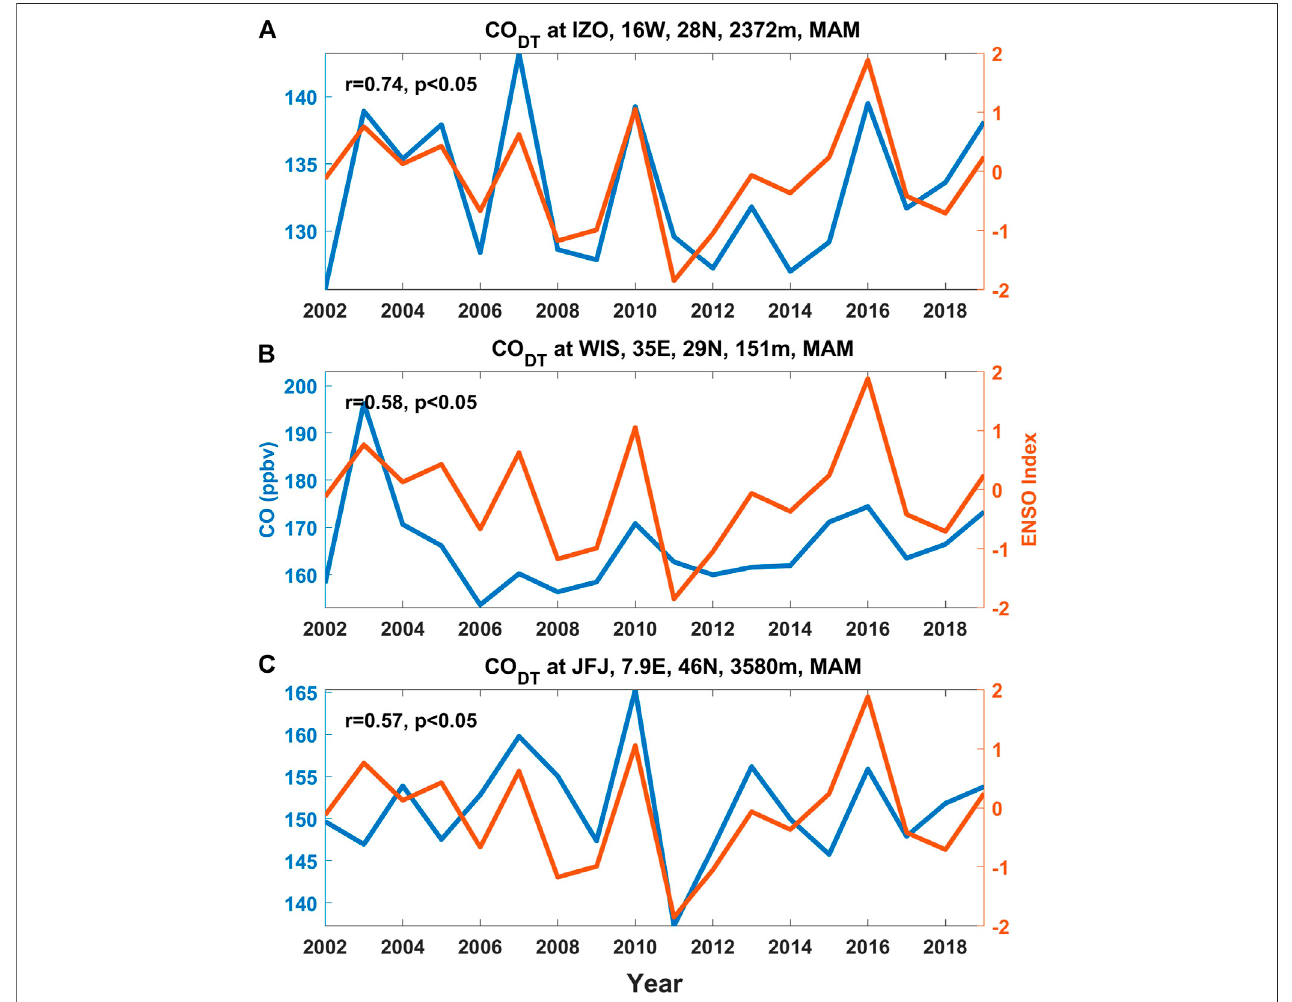
FIGURE3| InterannualvariationindetrendedCOconcentrationsinthesurfacelayer(CO DT ,blueline)atthreestationsinspringandtheENSOindexintheprevious winter (brown line). The correlation coef fi cient ( r ) and its p -value ( p ) between the two series are also shown. The three ground-level sites are (A) IZO (Izaña), 16 ° W, 28 ° N, 2,372 m, (B) WIS (Sede Boker), 35 ° E, 29 ° N, 151 m, and (C) JFJ (Jungfraujoch), 7.9 ° E, 46 ° N, 3,580 m.